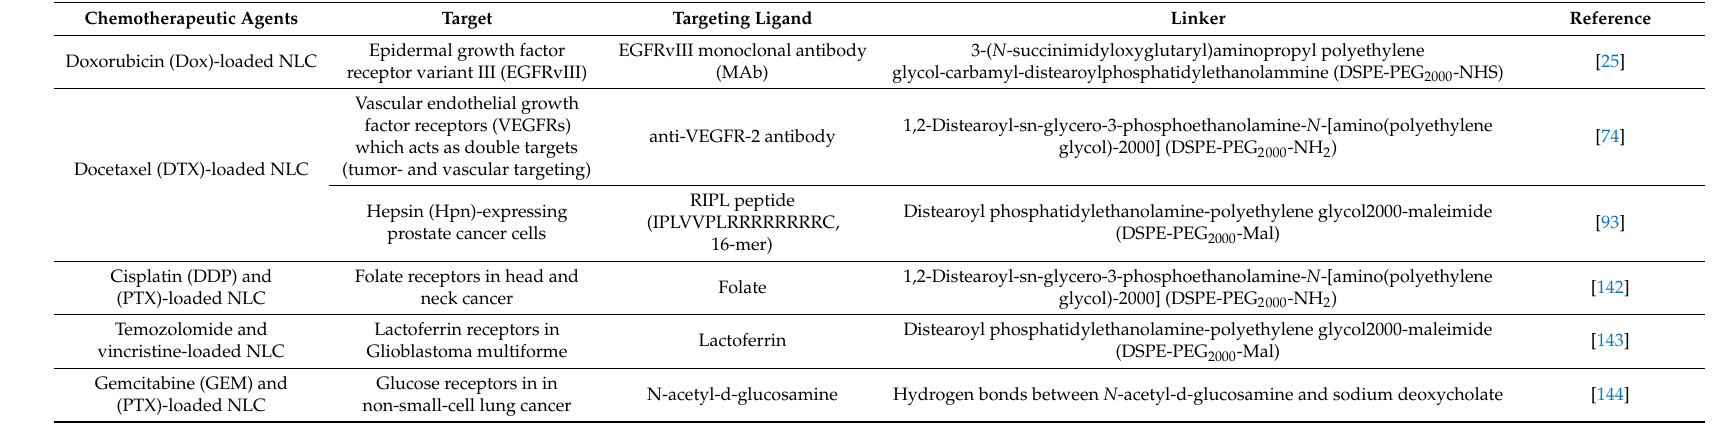
Table 4. Examples of targeted-NLCs loaded with chemotherapeutic